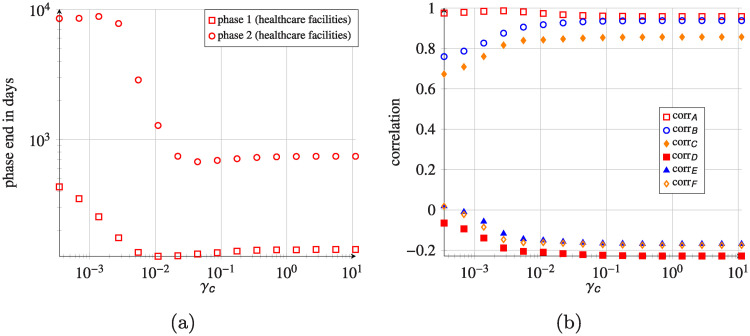
System-wide phase ends in healthcare facilities and correlation coefficients.(a) System-wide phase ends in healthcare facilities for different γc. (b) Dependence of the correlation coefficients on γc value (semi-log scale), corrA is the correlation coefficient between final hospital prevalences and corresponding communities prevalences; corrB—correlation coefficient between final hospital prevalences and average length of stay in hospitals; corrC—correlation coefficient between final community prevalences and average length of stay in corresponding hospitals; corrD—final prevalence in hospitals and hospital in-degrees; corrE—final prevalence in hospitals and hospital out-degrees; corrF—final prevalence in community nodes and community out-degrees. Initial condition for all simulations is the same 0.1% uniformly-distributed colonized patients.